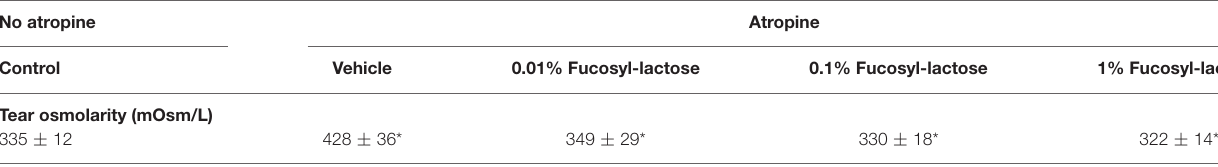
TABLE 2 | Tear osmolarity after 24 h from the first atropine administration. No atropine